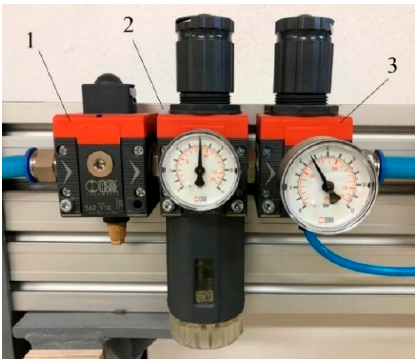
Figure 6. Preparatory group: 1. Cut-off switch, 2. Main regulator, 3. Additional regulator.